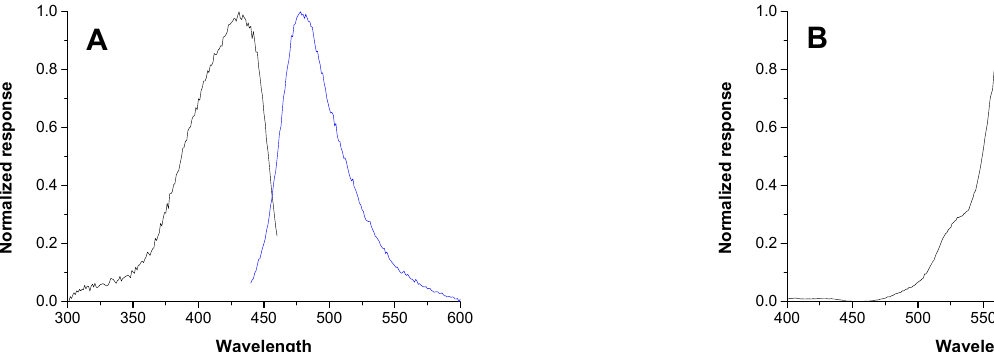
Figure 3. Normalized excitation (black line) and emission (blue line) spectra of 10 –5 M trypsin probe ( A ) and 10 –6 M chymotrypsin probe ( B ) in Tris-HCl buffer (pH = 8.0) measured at 37 °C.